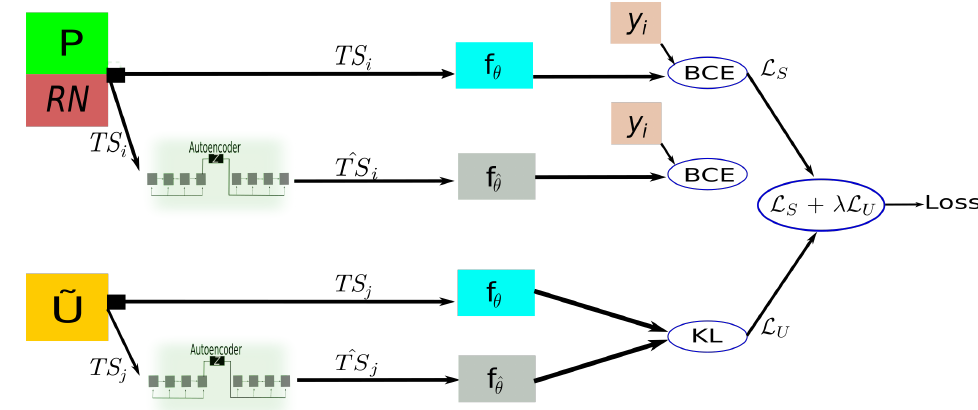
Figure 3. The training strategy involves two models trained simultaneously. The first model f ˆ is trained on the set of perturbed positive labelled P and reliable negative RN samples by the autoencoder with the supervised BCE loss on true labels y i . The second f θ is the final classification model trained on P and RN samples, with a semi-supervised process involving two losses: the binary cross entropy loss on the true labels y i ( L S ) and the KL divergence between the generated soft labels ( ˆ TS ) to enforce consistency ( L f θ ( TS j ) and f ˆ U ). The λ hyper-parameter weights the importance of j θ the unsupervised